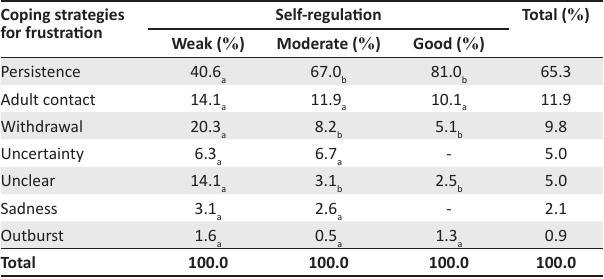
TABLE 2: The teacher-rated self-regulation skills and their relationship to the coping strategies of frustration. Coping strategies for frustration